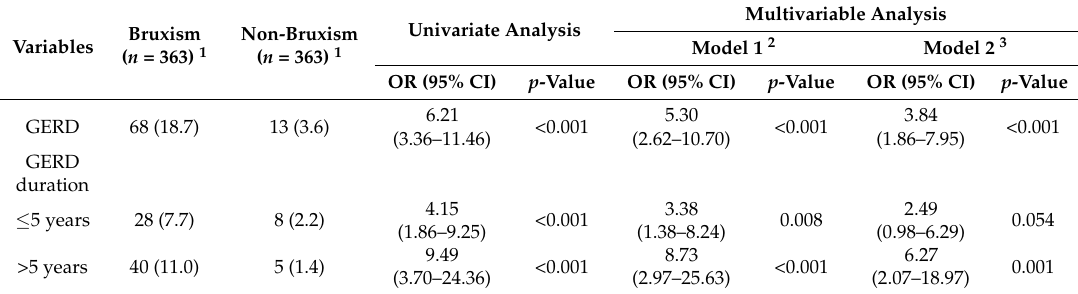
Table 1. Association between bruxism and GERD using conditional logistic regression.